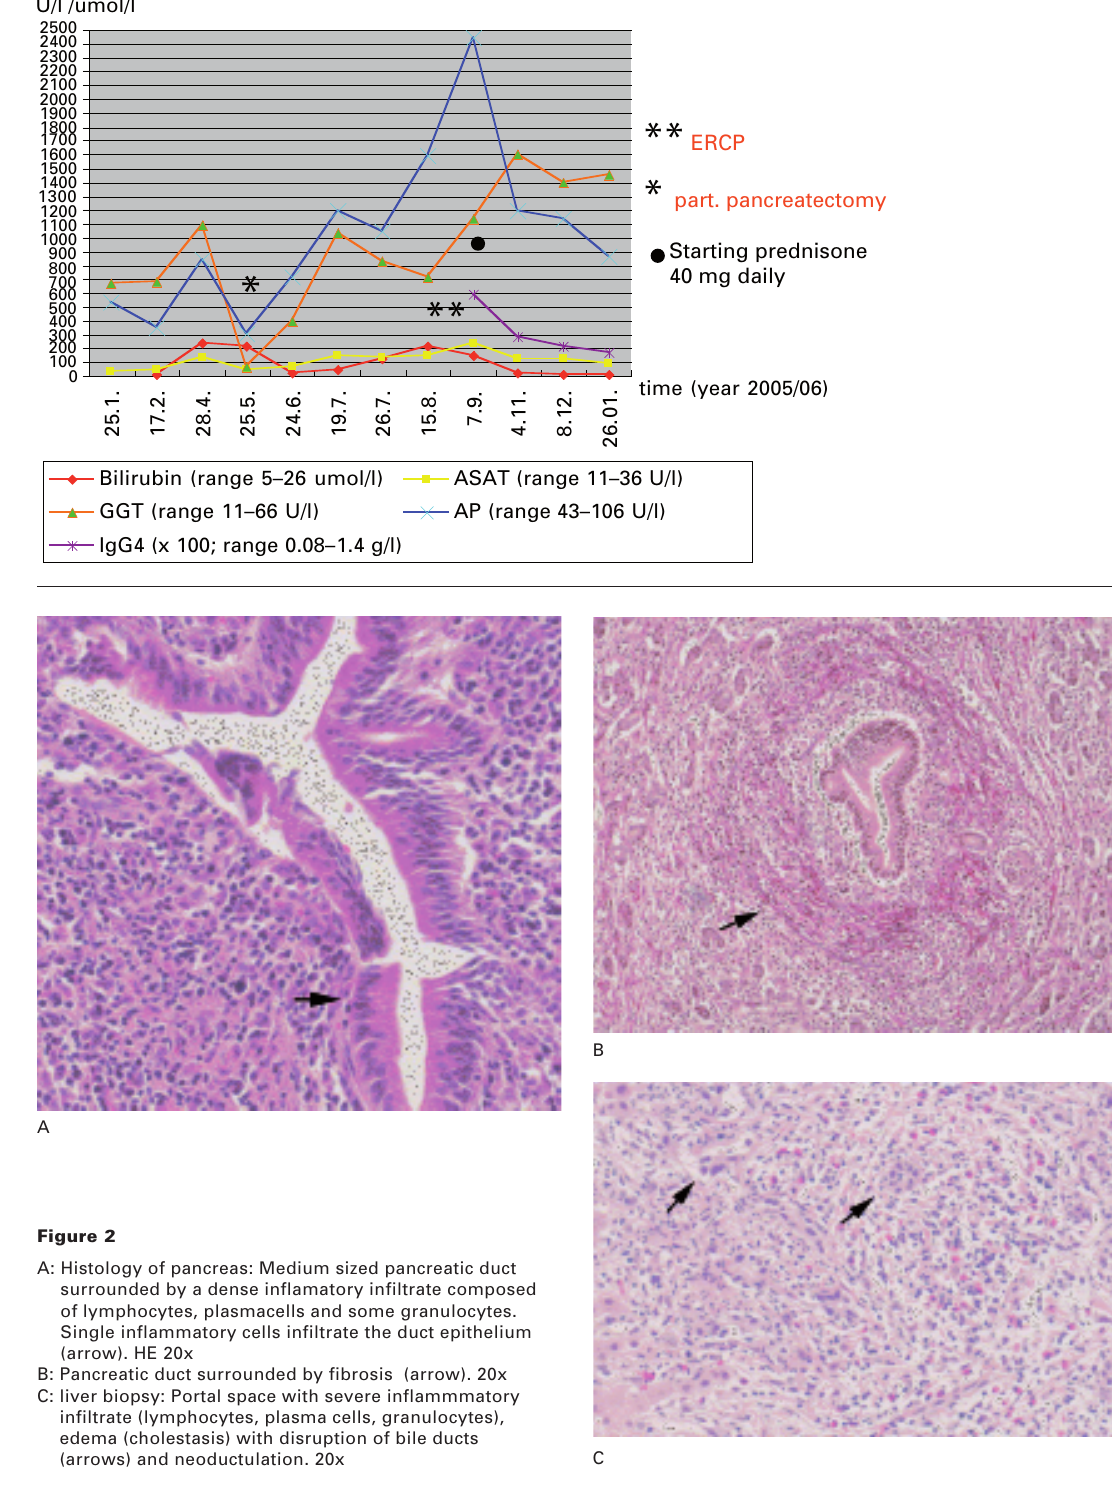
Figure 2 A: Histology of pancreas: Medium sized pancreatic duct surrounded by a dense inflamatory infiltrate composed of lymphocytes, plasmacells and some granulocytes. Single inflammatory cells infiltrate the duct epithelium (arrow). HE 20x B: Pancreatic duct surrounded by fibrosis (arrow). 20x C: liver biopsy: Portal space with severe inflammmatory infiltrate (lymphocytes, plasma cells, granulocytes), edema (cholestasis) with disruption of bile ducts (arrows) and neoductulation. 20x